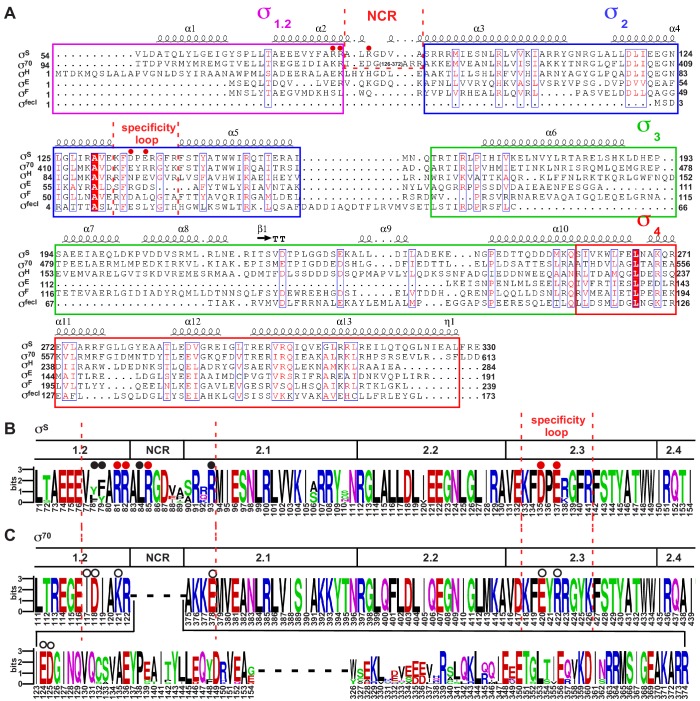
The sequence alignment of bacterial σ factors.(A) Sequence alignment of six σ70-type E. coli σ factors. (B) The sequence alignment of the σ70subunit of ten representative bacterial species (Proteus mirabilis, Escherichia coli, Salmonella enterica serovar Typhi, Yersinia enterocolitica, Shigella flexneri, Vibrio cholerae, Dickeya dadantii, Providencia stuartii, Xenorhabdus bovienii, and Photobacterium profundum). (C) The sequence alignment of the σS subunit of the same ten bacterial species. The residues are numbered as in E. coli.